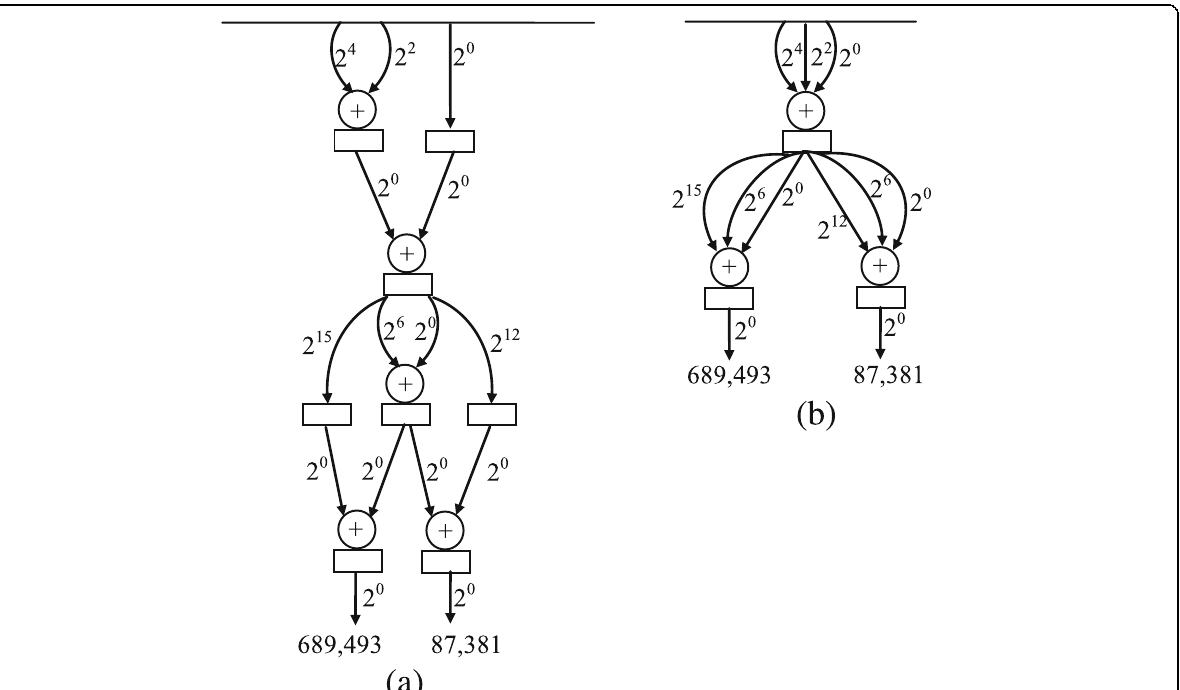
Fig. 13 a Two-input adder graph by PAG algorithm for the multiplier block {87,381; 689,493} and b three-input adder graph by PAG algorithm for the multiplier block {87,381;